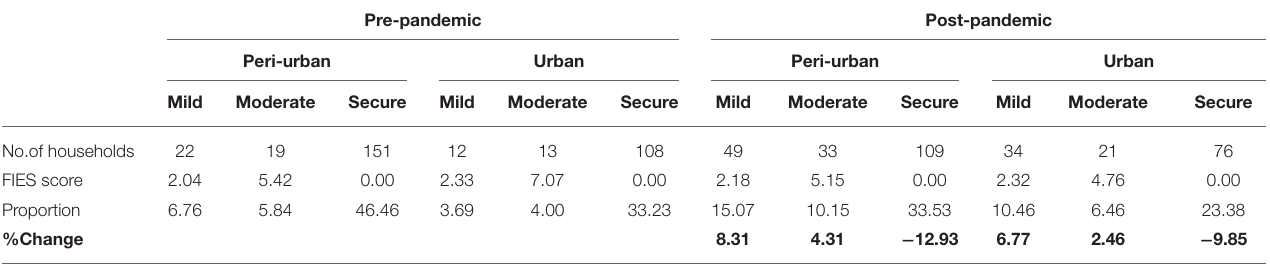
FIES score is the number of affirmative responses of the households to the Food Insecurity Experience Scale